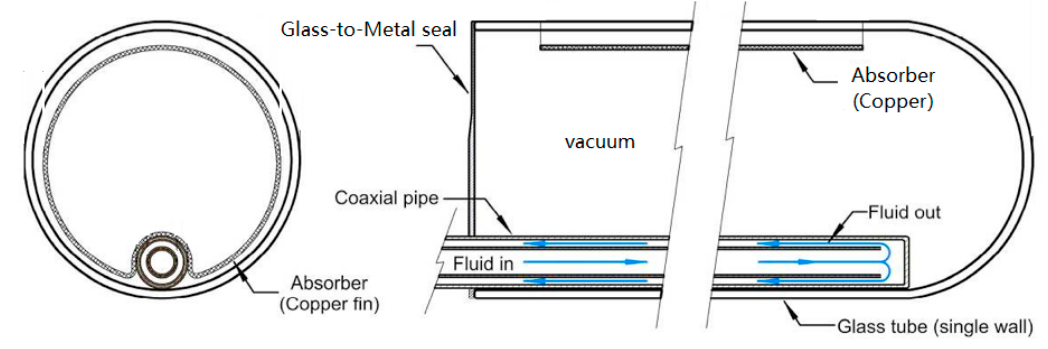
Figure 21. Schematic of CPC with coaxial pipe [51].